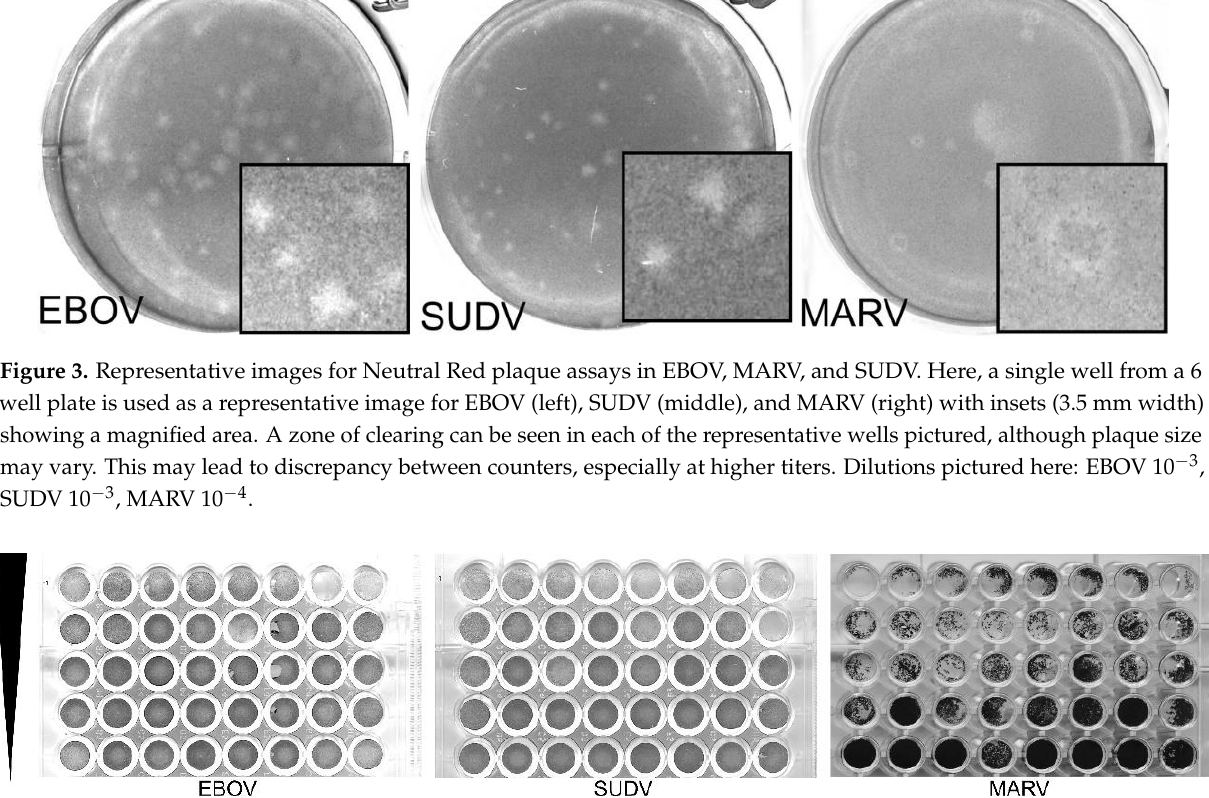
Figure 4. Representative images for TCID 50 (Tissue Culture Infection Dose, 50%). Here, a representative image for EBOV (left), SUDV (middle), and MARV (right) is shown. Each column is a replicate (From the top), with each descending row increasing in dilution. The directional arrowhead denotes the virus concentration gradient, from high (top) to low (bottom) virus concentration. Titer is estimated by gross cell death within the replicates of each dilution using the Reed–Muench calculation [5].